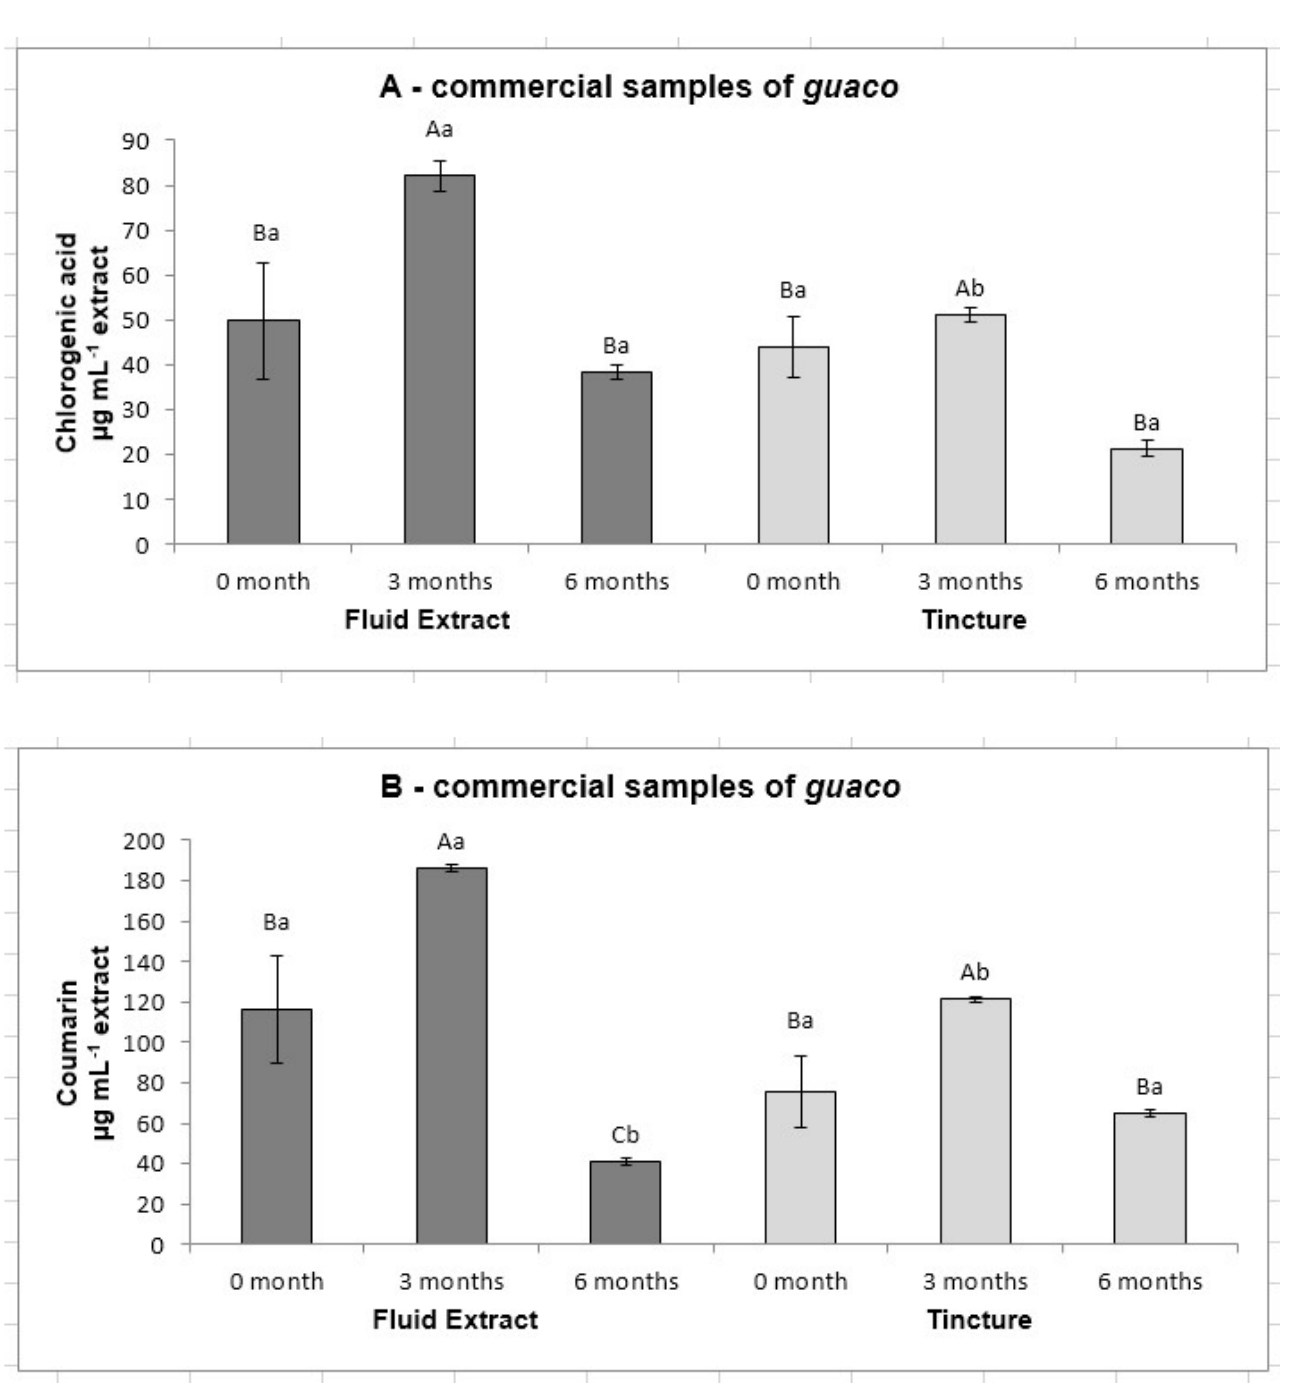
FIGURE 5 - Variation of the content of chlorogenic acid (A) and coumarin (B) in commercial samples of guaco (Fluid Extract and Tincture of guaco ) subjected to accelerated stability study (40 ºC). Capital letters indicate statistically significant (p<0.05) differences for the same sample lowercase letters indicate statistically significant (p<0.05) differences between samples. Experiment performed in triplicate. Error bars indicate standard